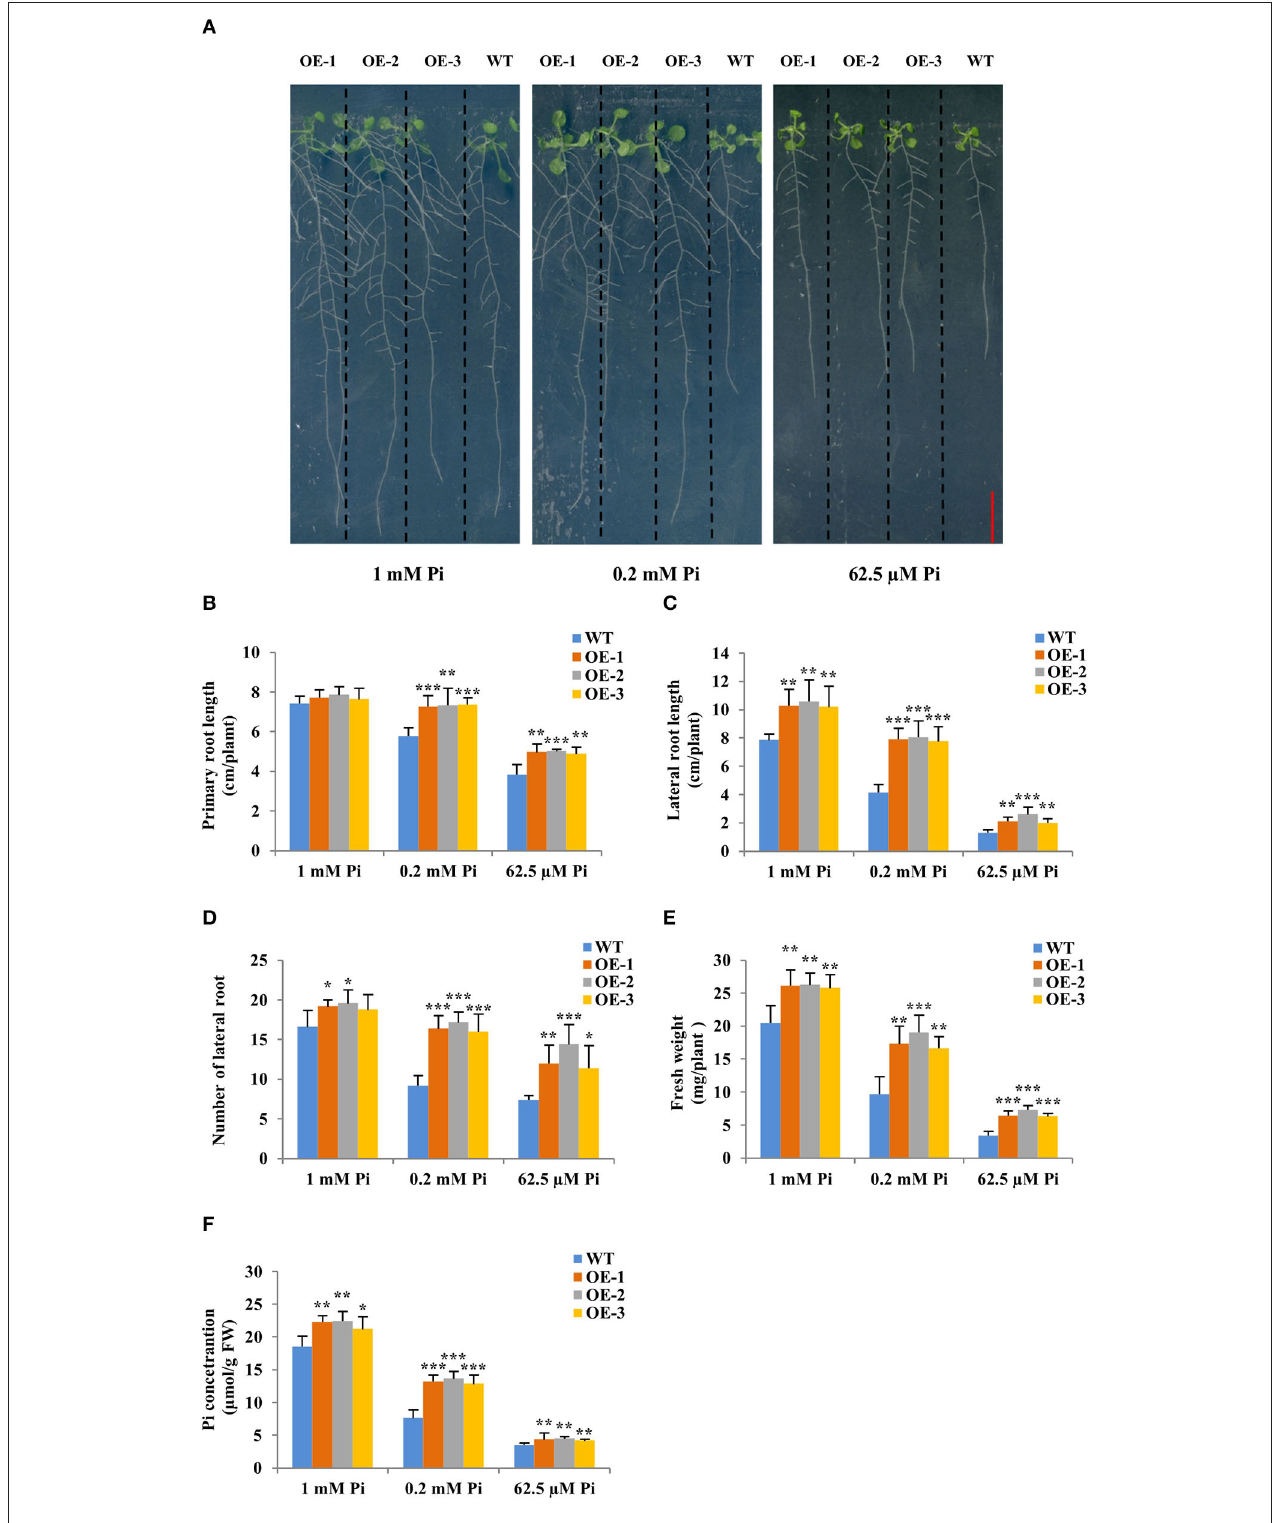
FIGURE 4 | Overexpression of GmWRKY46 enhanced Pi starvation tolerance and lateral roots growth in transgenic Arabidopsis . (A) WT and GmWRKY46-overexpressing transgenic Arabidopsis were grown under three different Pi concentrations (Pi-sufficient, 1mM Pi; Pi-deficient, 0.2mM Pi and 62.5 µ M Pi) for 15 days on vertically oriented petri plates, respectively. Primary root length (B) , lateral root length (C) , number of lateral root (D) , fresh weight (E) , and Pi concentration (F) were determined in WT and transgenic Arabidopsis plants on the 15th day. Values were mean ± SD ( n = 3), and asterisks showed that the values were significantly different between the transgenic lines and the WT (Student’s t -test, * P < 0.05, ** P < 0.01, *** P < 0.001).